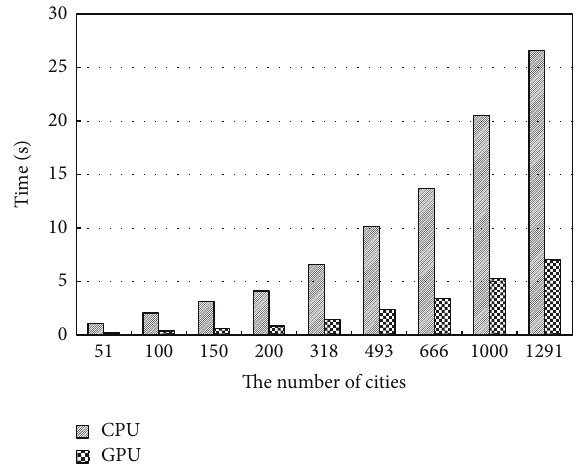
Figure 5: Runtime (s) of CPU and GPU implementation of the membrane algorithm having 200 cells on TSP with different numbers of cities. Table 2: Runtime (s) of CPU and GPU implementation of the membrane algorithm with different numbers of cells on TSP benchmark problem with 493 cities.